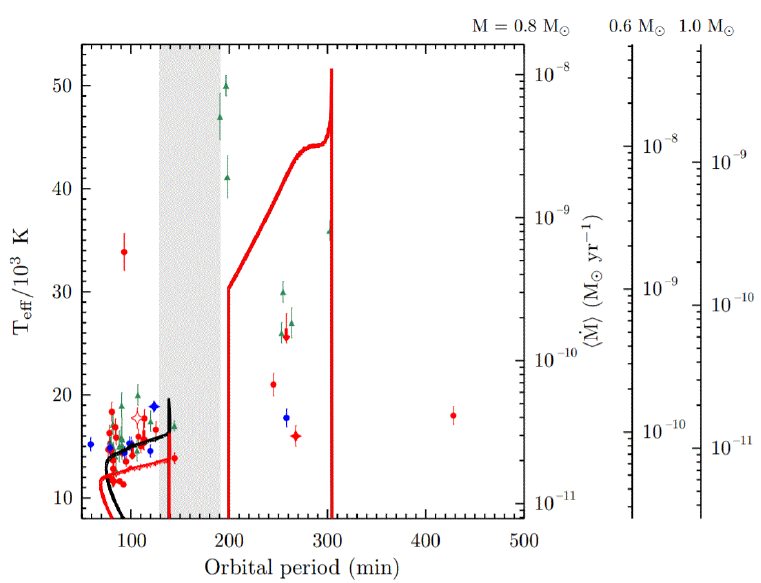
Figure 1. The WD effective surface temperature as a function of the orbital period from [15] (red and blue dots) and from [14] (green, non-magnetic system). The vertical light gray band represents the period gap between 2 and 3 h. The solid lines represent the evolutionary tracks for a system with a 0.8 M (cid:12) WD accreting from a donor with an initial mass of 0.65 M (cid:12) , and an initial orbital period of 12 h. The red track was generated with the classical recipe for CV evolution (gravitational wave radiation only below the period gap), while the black track includes a residual magnetic braking equal to the gravitational radiation AML when the donor has no radiative core. The two tracks overlap above the period gap. To the right of the panel is projected a mapping to < ˙ M > from [14] for M wd = 0.8, 0.6, and 1.0 M (cid:12) , respectively. Note the paucity of CV systems with exposed WD above the period gap. The number of CVs with exposed WDs above the period gap is only 20% of the CVs below the period gap. This figure was taken from